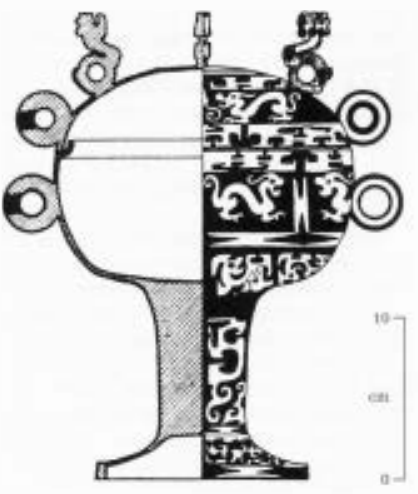
Figure 2 Part of the burial site of Shangyejie in Chengdu city showing the excavated boat coffins made from tree